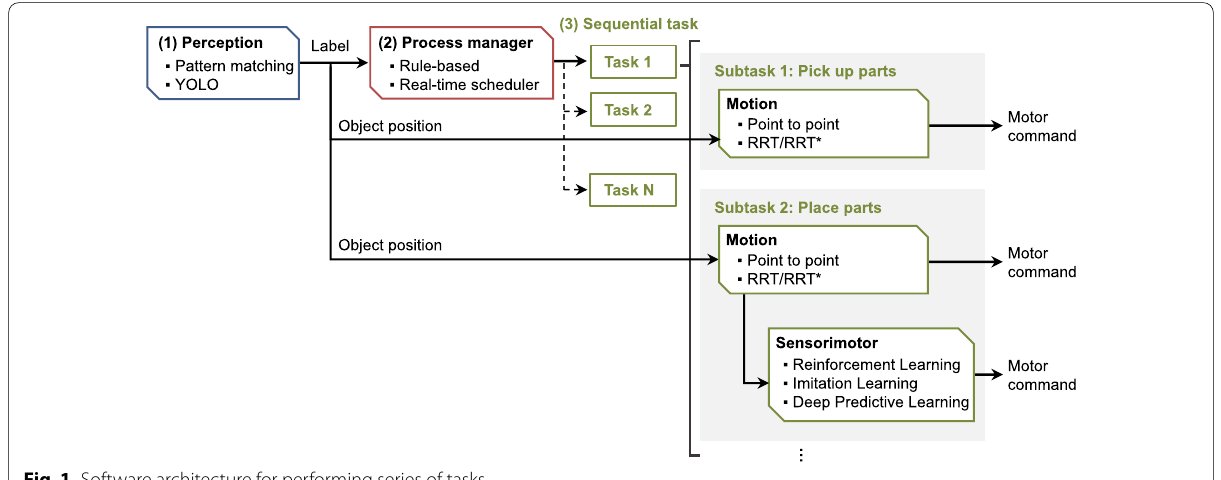
Fig. 1 Software architecture for performing series of